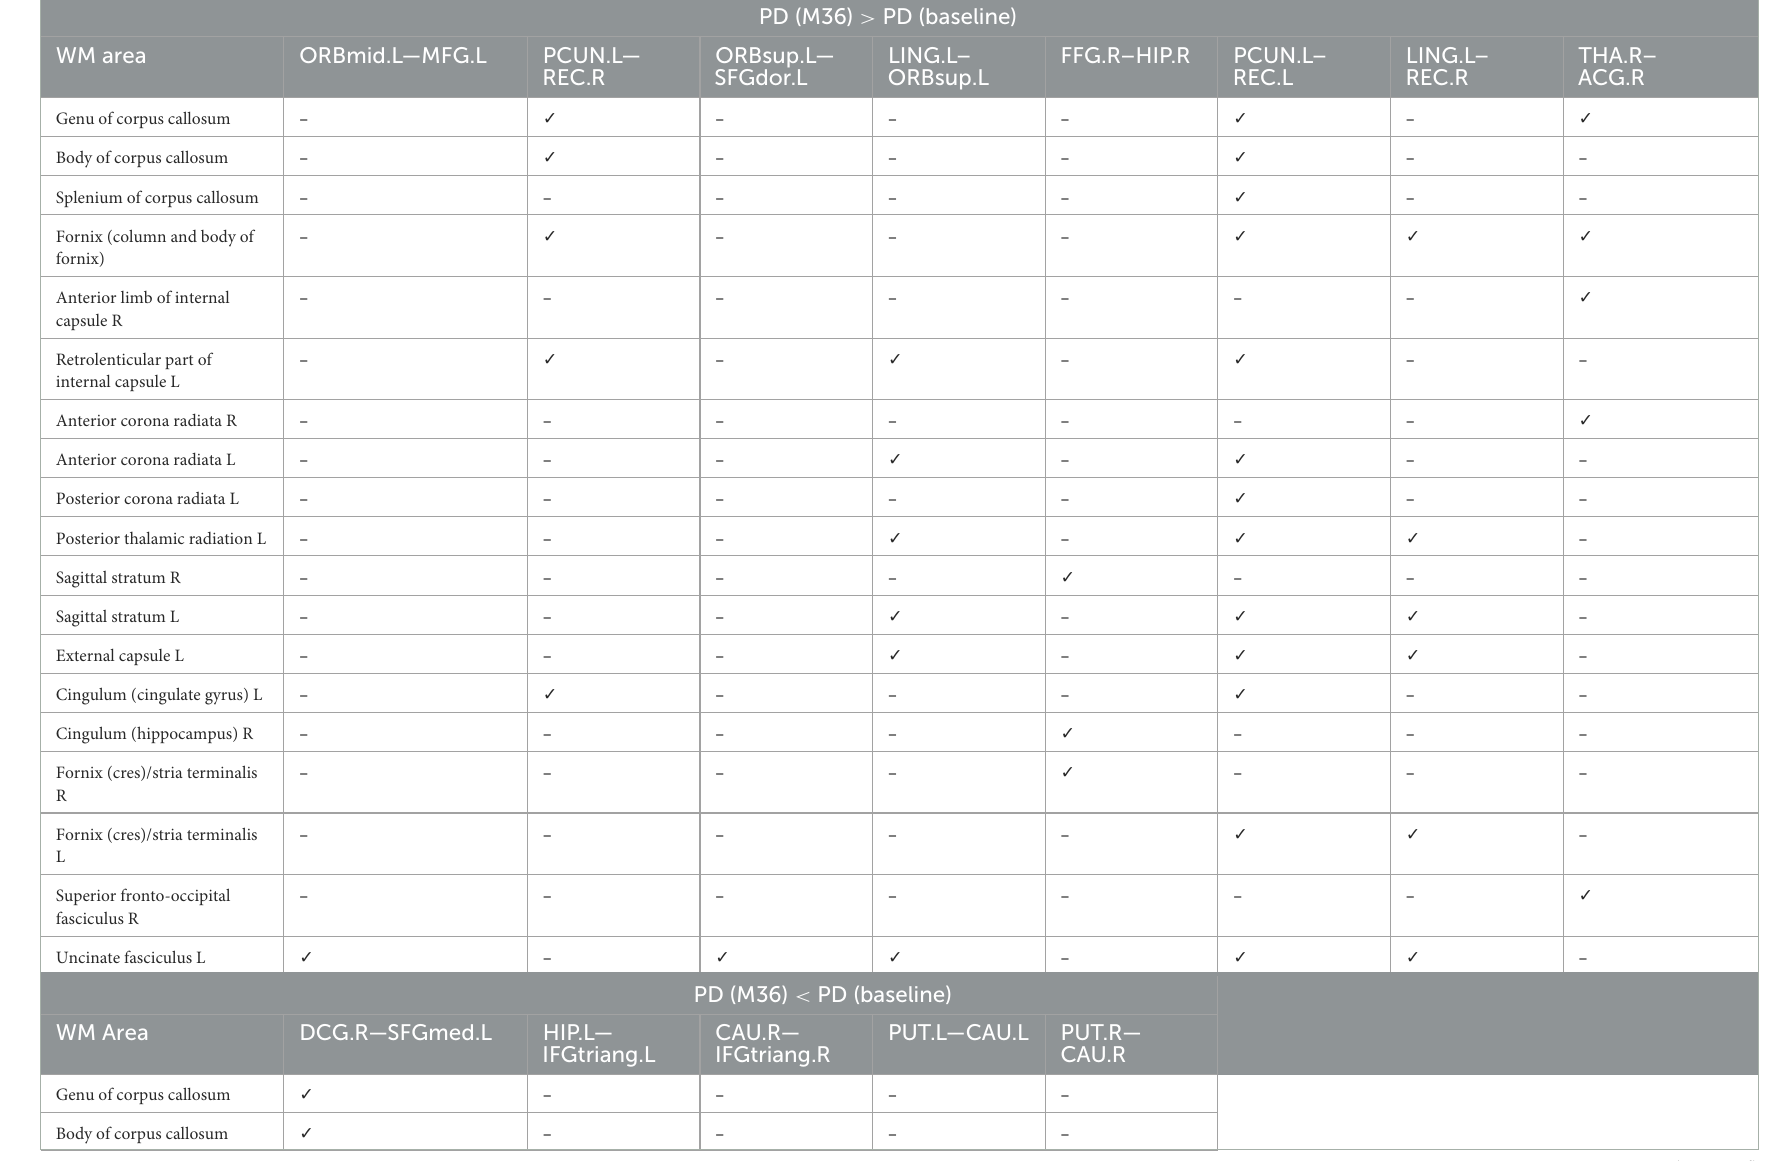
TABLE 3 WM areas where we found altered sstructural connectivity in PD between baseline and M36 (longitudinal analysis), as indicated by 3